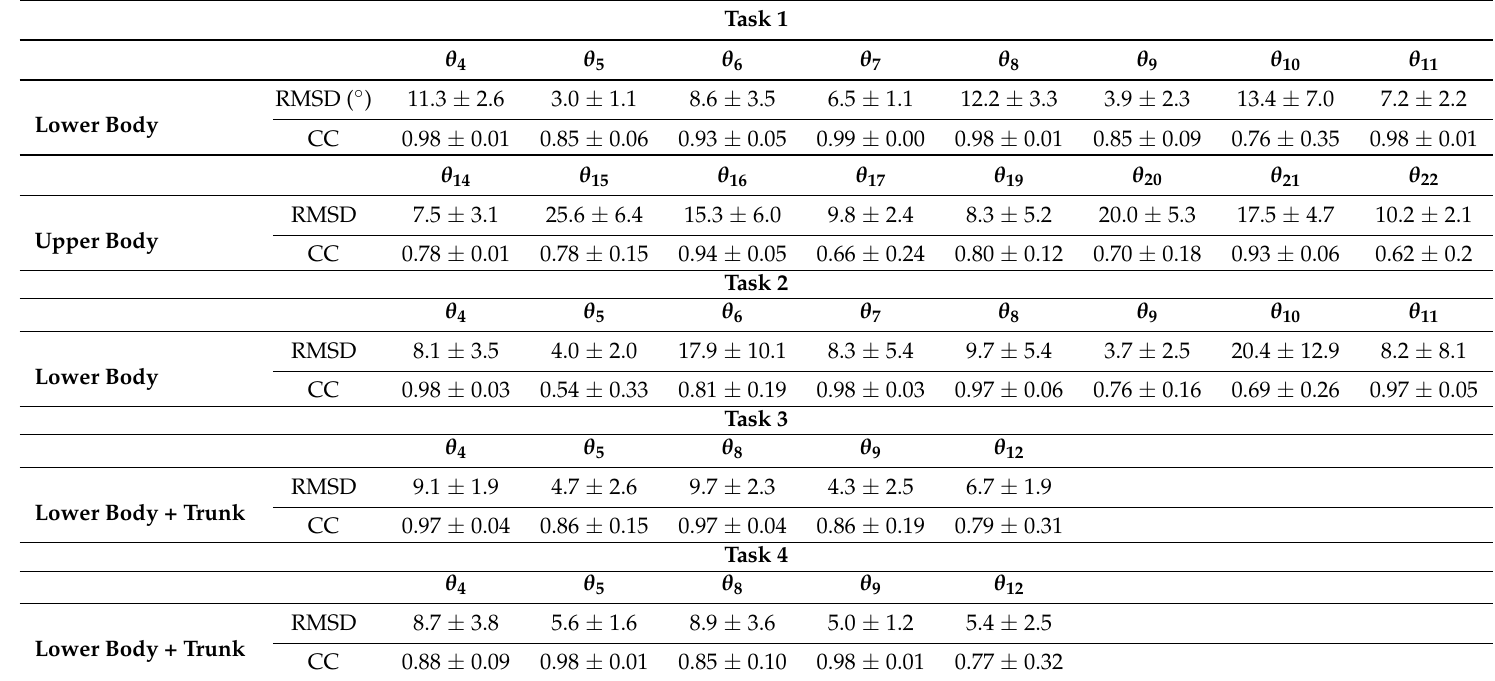
Table 1. Joint angle estimation obtained using the optimal tuning of Q . Accuracy for angles of interest have been reported as mean ± SD over all the analyzed trials. RMSD: root mean square difference; CC: correlation